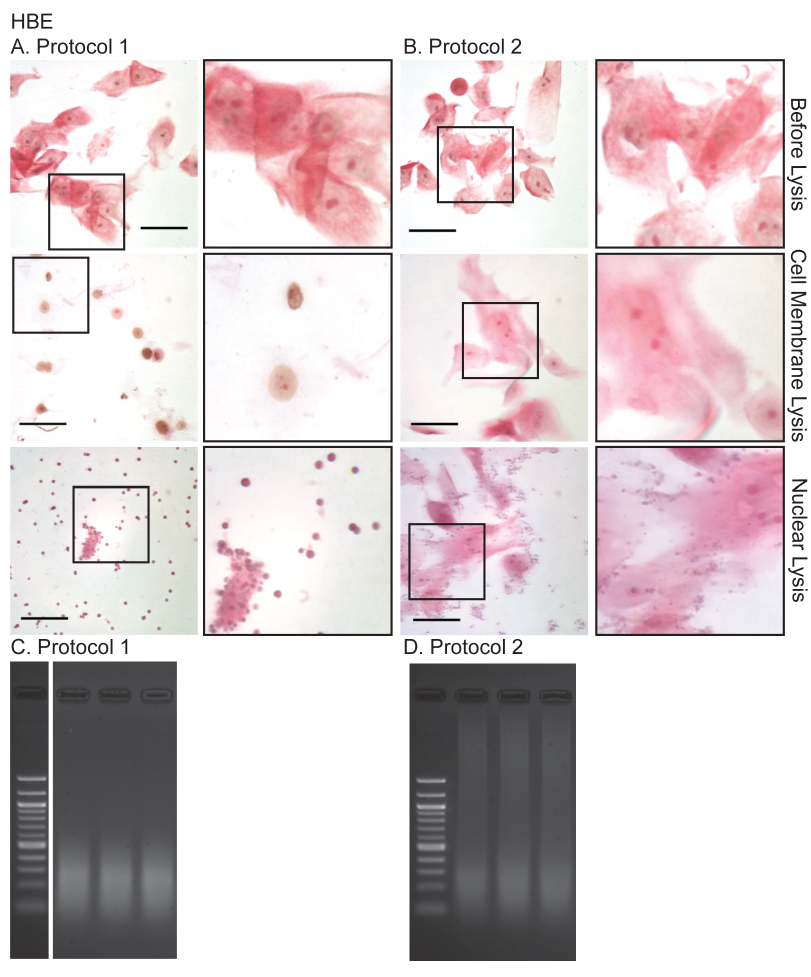
Figure 1. Light microscopy of Methyl Green-Pyronin stained primary human airway epithelial (HBE) cells during the modified (A, Protocol 1) and unmodified (B, Protocol 2) and resulting sonicated chromatin (C, D), separated on 2% agarose gels post-stained with 0.01% ethidium bromide. Note, the sheets of cells have not lysed during protocol 2 and the resulting sheared DNA is of poor quality for ChIP. Methods as described in the text. Scale bar=50 m m.